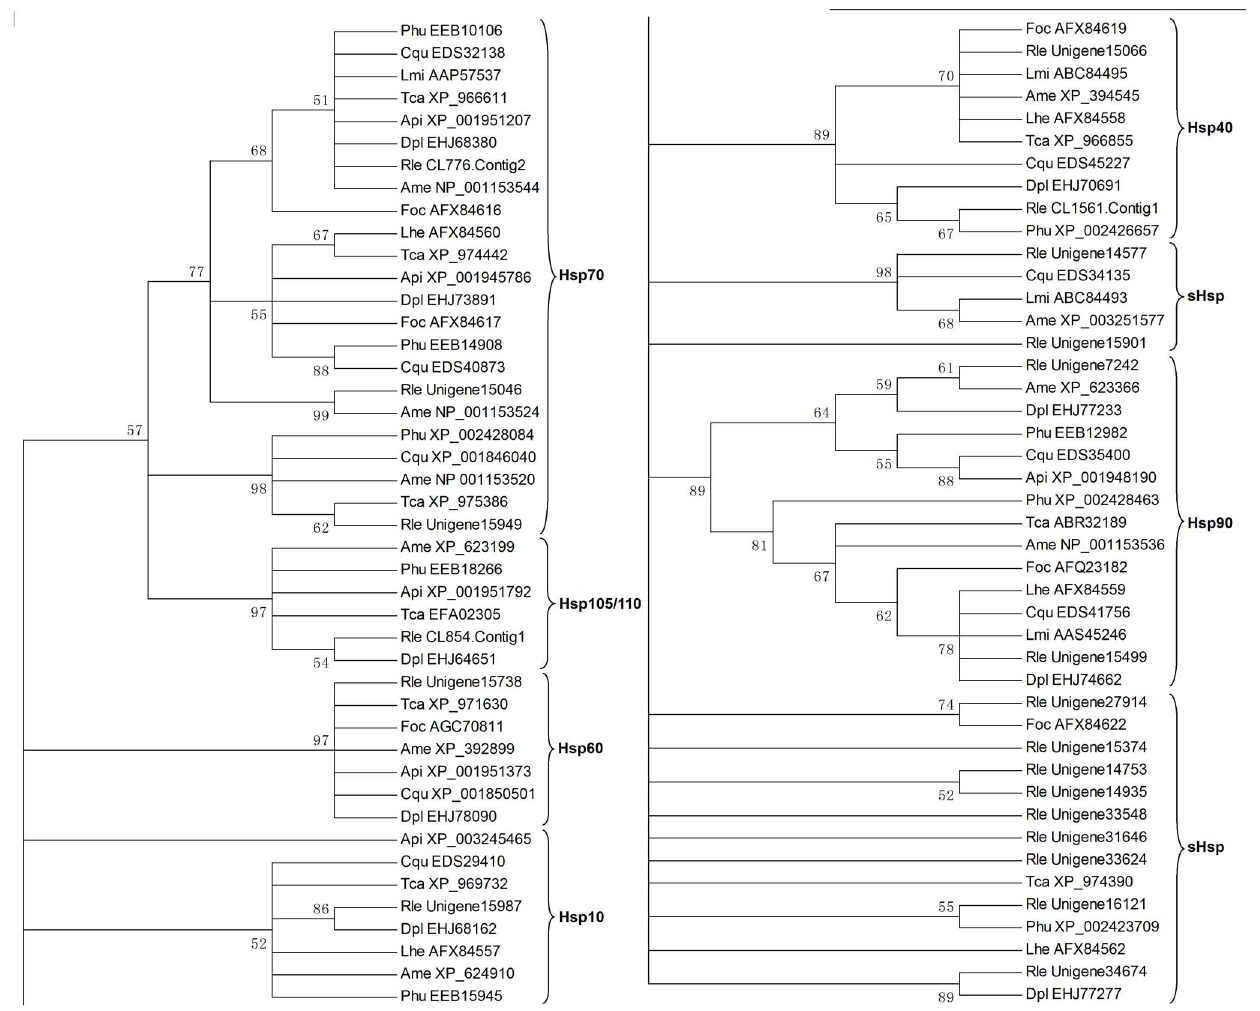
Figure 4. Phylogenetic analysis of heat shoch protens from different insects. Analyses were performed using only sequences predicted to encode complete ORFs. The tree is a 50% consensus tree. Abbreviations are as follows: Api, Acyrthosiphon pisum ; Ame, Apis mellifera ; Cqu, Culex quinquefasciatus ; Dpl, Danaus plexippus ; Foc, Frankliniella occidentalis ; Lmi, Locusta migratoria ; Lhe, Lygus hesperus ; Phu, Pediculus humanus corporis ; Rle, Rhyacionia leptotubula ; Tca, Tribolium castaneum